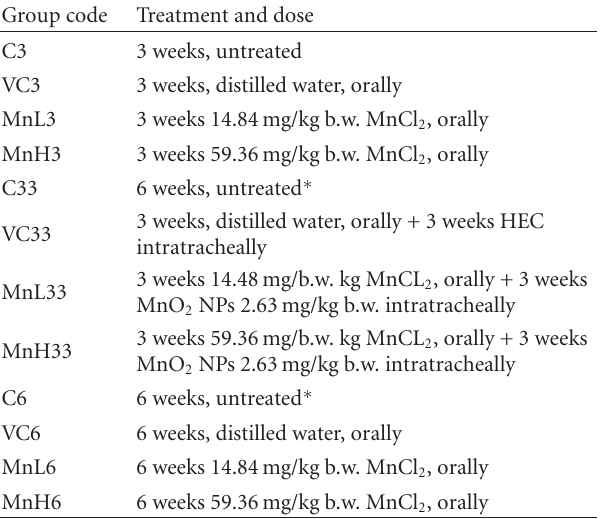
Table 1: Treatment scheme with group codes, doses and treatment times.